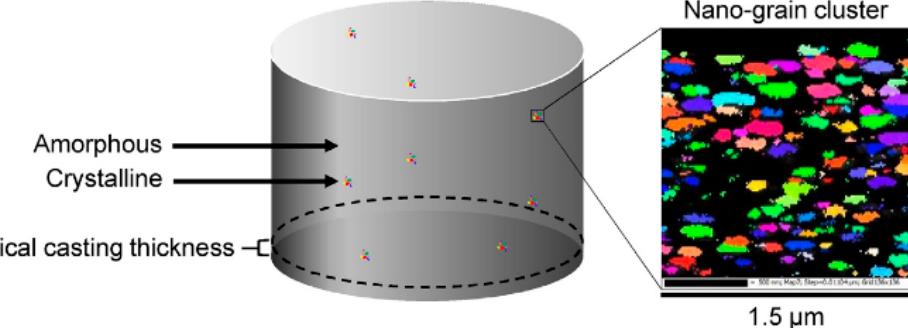
Figure 7. Nanograin clusters in the cylinder: Electron backscatter diffraction (EBSD) micrograph showing a nanograin cluster in the FeCrMoCB bulk cylinder (reprinted with the permission from [61], Elsevier, 2018).